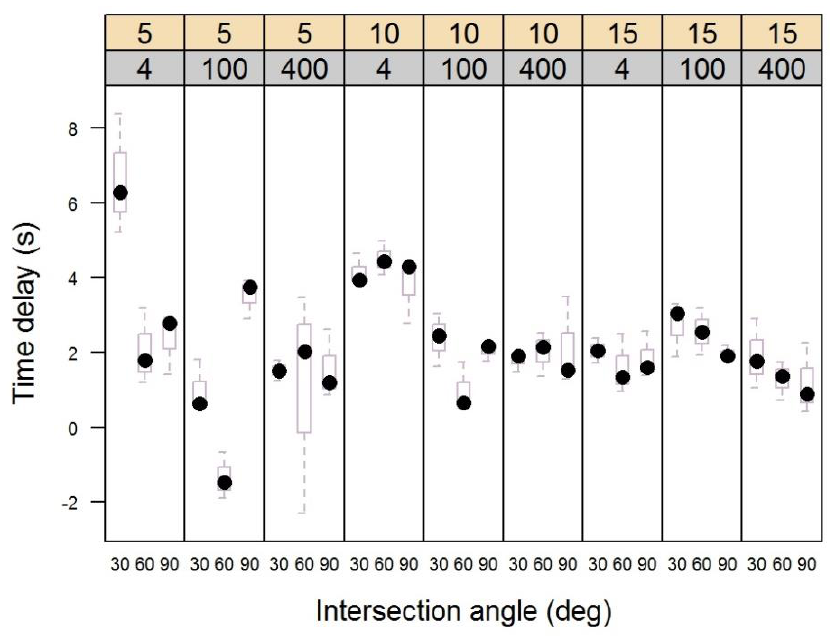
Figure 2. Box-and-whiskers plot showing the time difference between actual run time and the time as measured with the geofence crossing signal. Upper panel numbers are speed (5 kph, 10 kph, 15 kph). Sub-panel scale is receiver distance (4 m, 100 m, 400 m).